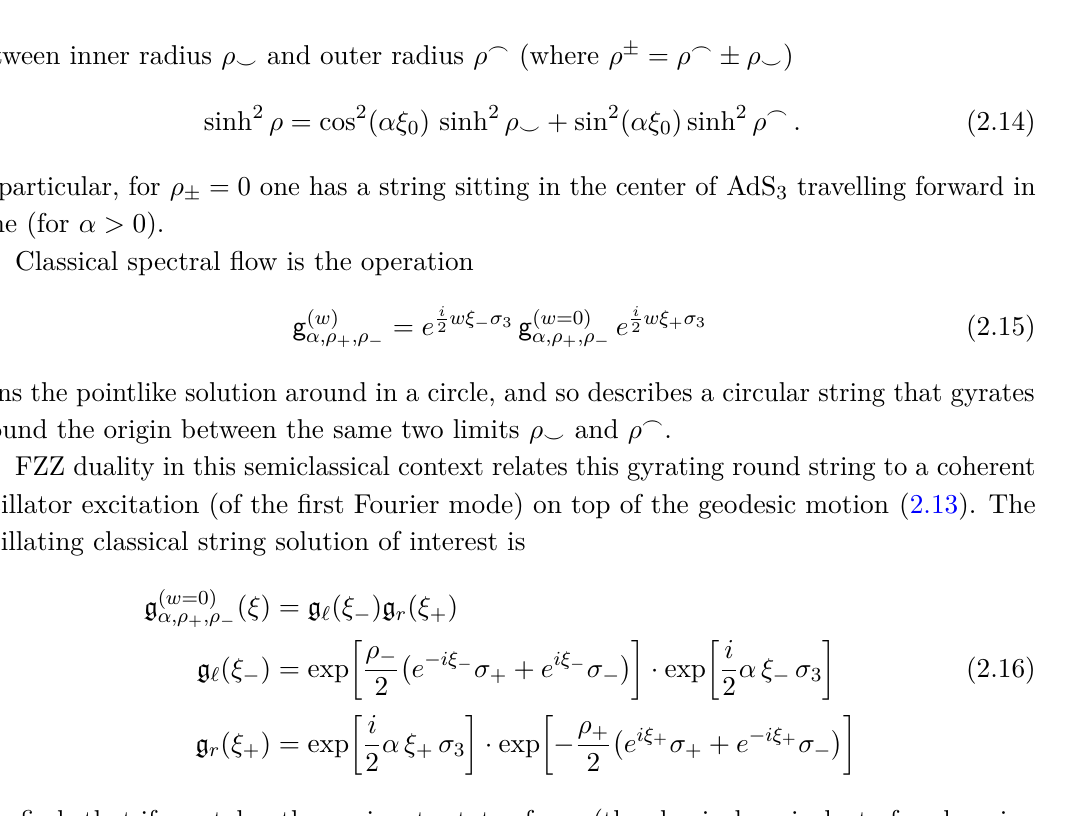
Figure 2. Classical closed string solutions in AdS 3 : (a) Highest weight states describe unexcited strings sitting at the origin (black trajectory), with zero mode descendants (red trajectory) describing strings oscillating about the origin having no oscillator excitations. Spectral flow spins a geodesic around ρ = 0 , describing strings that “wind” azimuthally, with zero mode descendants exciting a breathing mode oscillation (green worldsheet). (b) Spectral flow of spacelike geodesics describes scattering states where the wound string approaches the AdS boundary in the far